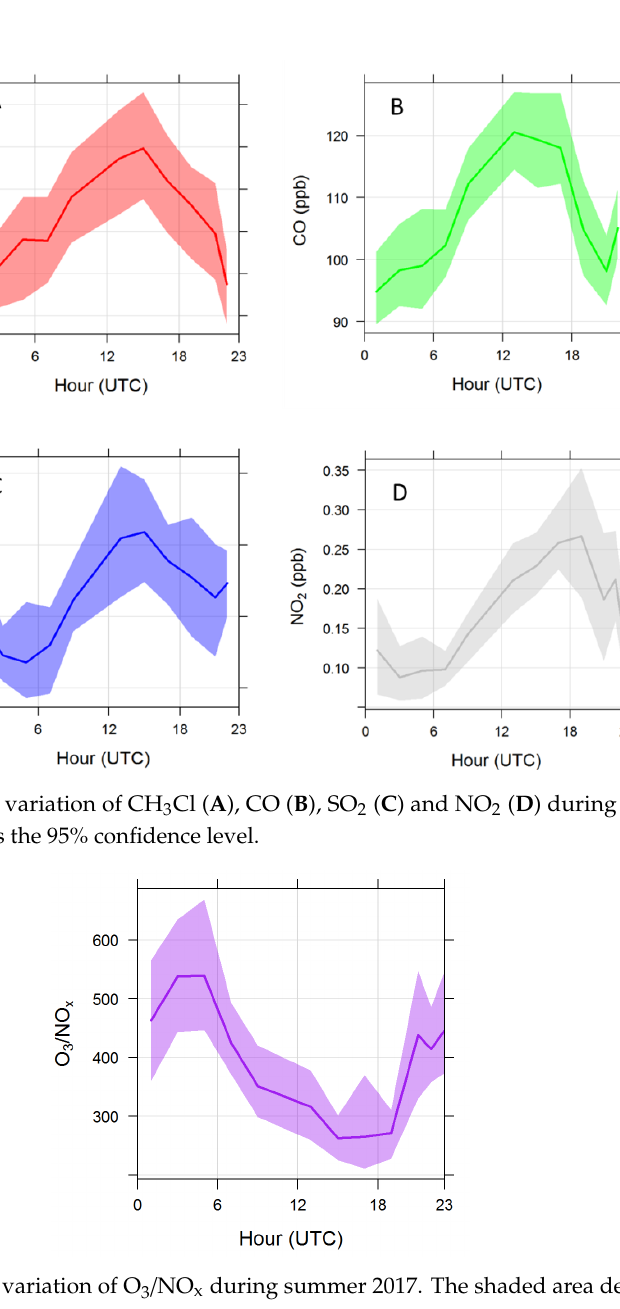
Figure 4. Averaged diel variation of O 3 / NO x during summer 2017. The shaded area denotes the 95% confidence level.